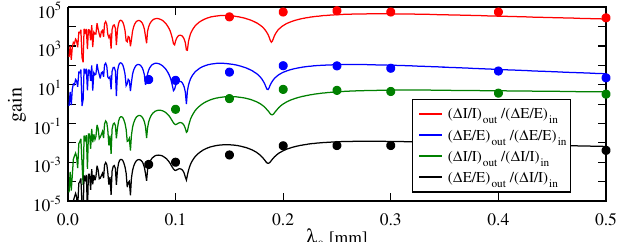
FIG. 12. (Color) Curves show the analytical microbunching gain between the entrance of the BC1 chicane at 215 MeVand the exit of the L2 linac at 1.7 GeV, for a bunch with initial current of 50 A. The gain is calculated as a function of the modulation’s initial wavelength (cid:6) 0 , for a semicircular energy distribution from a matched laser heater with initial rms energy spread of 10 keV. Plotted points show the gain in ELEGANT simulations of 1– 3 million particles, for a 200-pC bunch with a parabolic longi- tudinal profile with initial rms bunch length of 400 (cid:2) m and peak current of 50 A. In the simulations, a bunch with an initial 3-keV Gaussian energy distribution is heated by 10 keV in an ELEGANT simulation of a matched laser